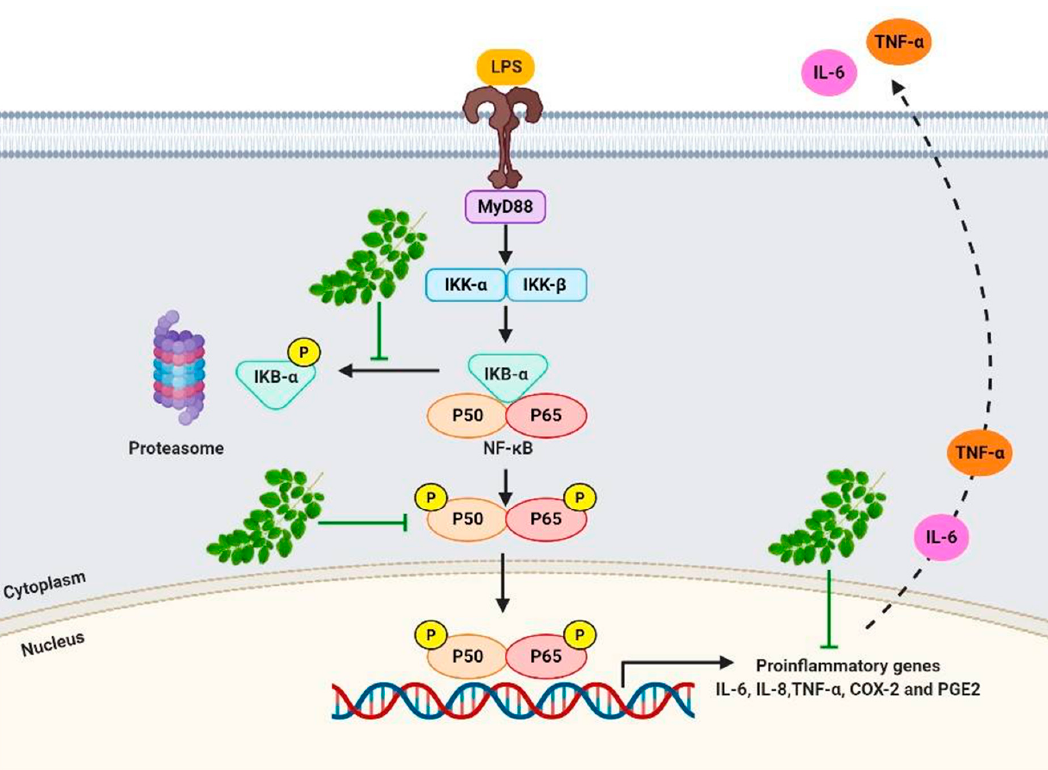
Figure 7. Mechanism of anti-inflammation of MO in LPS-induced macrophages.